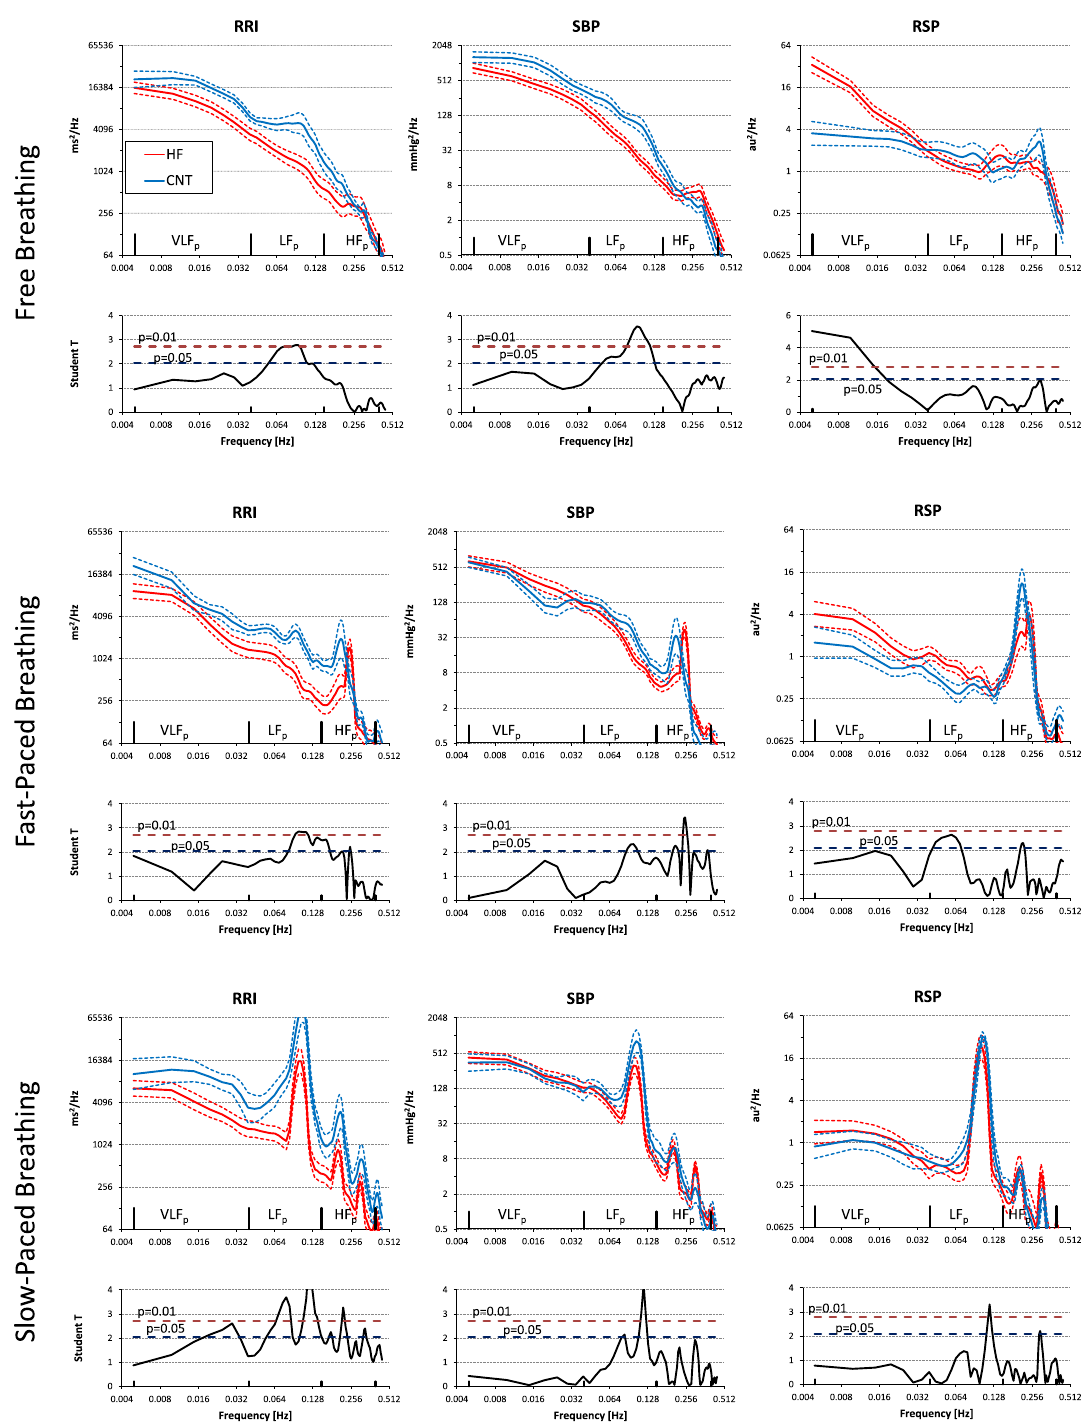
Figure 2. Power spectra during free, fast-paced, and slow-paced breathing. Power spectra in heart failure (HF) patients and controls (CNT) are shown as geometric mean ± geometric sem separately for R–R intervals (RRI), systolic blood pressure (SBP), and respiration (RSP). Panels below each couple of CNT and HF spectra show the Student T statistics between groups at each frequency, with horizontal dashed lines indicating the 0.05 and 0.01 significance thresholds: this means that T-values above the dashed lines point out differences between HF and CNT groups significant at the corresponding significance threshold. Frequency bands defining the very-low frequency power (VLF p ), low-frequency power (LF p ) and high-frequency power (HF p ) are shown. Note the lower SBP and RRI powers around 0.1 Hz and the greater VLF p of RSP for the HF group during free